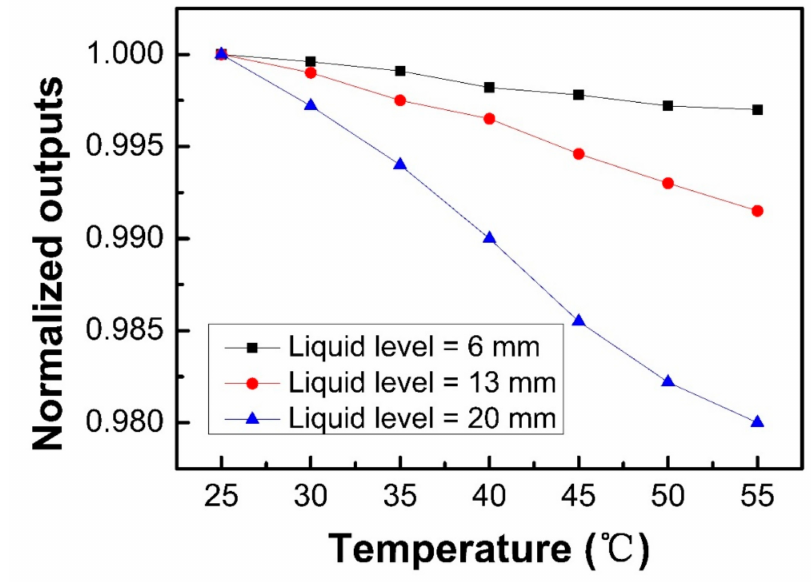
Figure 7. The dynamic performance ( a ) and the measured response time ( b ) of the sensor where the V-groove pitch, depth, and angle of the sensor probe are 1 mm, 100 µ m, and 60 ◦ , respectively, and the refractive index of the testing liquid is 1.39.